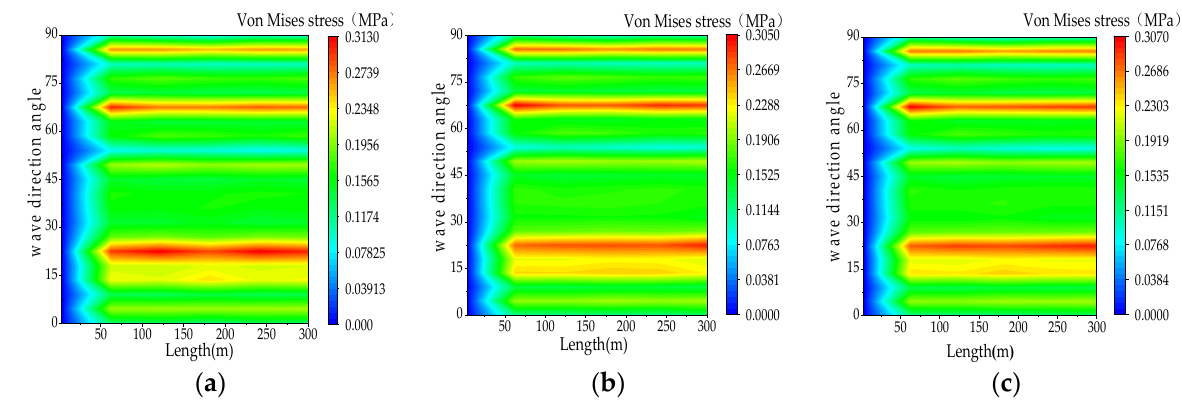
Figure 13. Von Mises stress variation clouds under different wave directions. ( a ) t = 40 s; ( b ) t = 70 s; ( c ) t = 140 s.